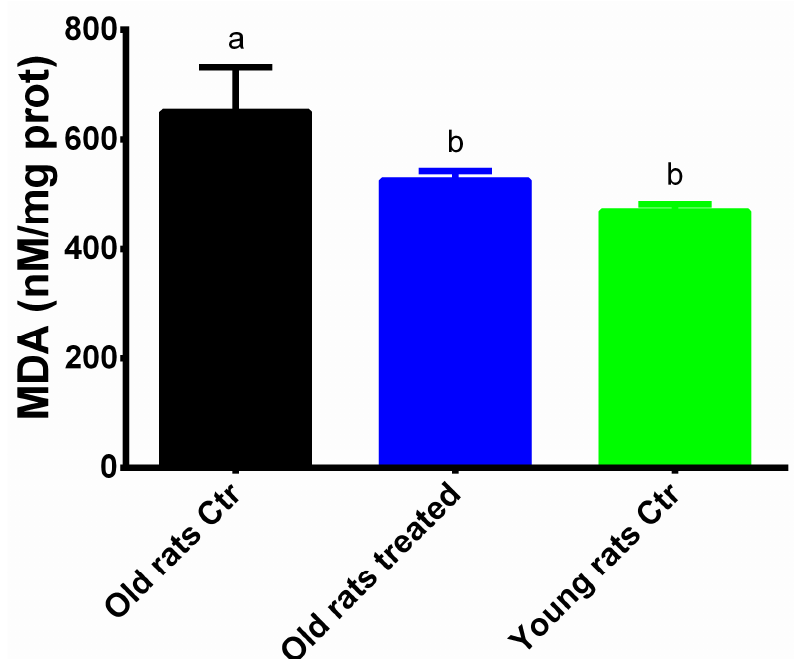
Figure 5. Levels of MDA. Results are expressed as mean ± SEM, and p < 0.05 was considered statistically significant. Statistical significance was calculated by one-way ANOVA analysis. Di ff erent letters reveal significant di ff erences. Old rats Ctr refers to old animals treated with placebo; Old rats treated refers to old animals treated with Taurisolo ® ; Young rats Ctr refers to young animals treated with placebo. Abbreviations: MDA, malondialdehyde.